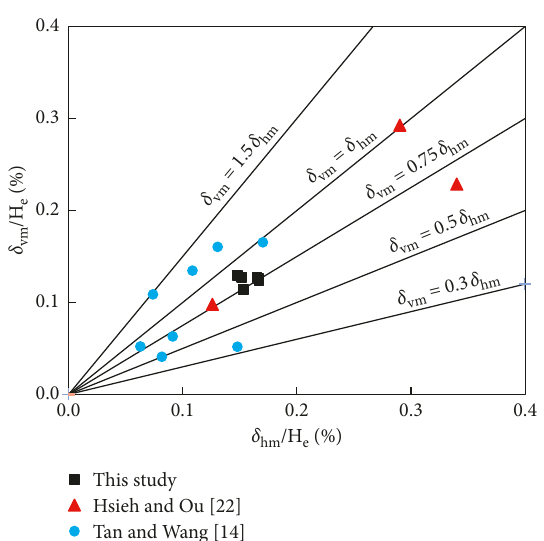
v / δ vm and d /H e .